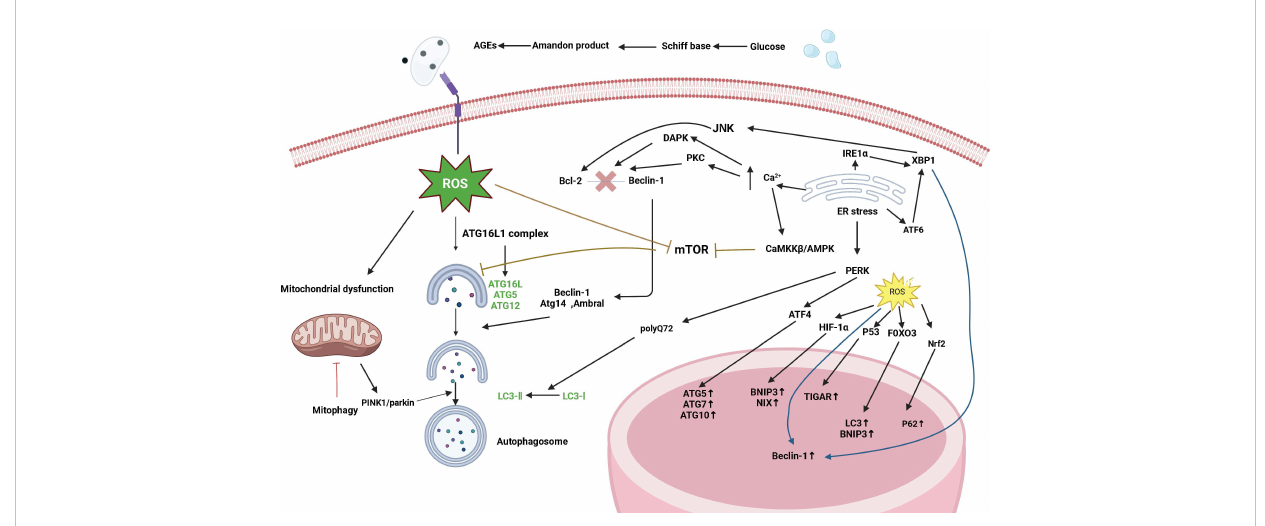
FIGURE 2 Signaling pathways are regulated by autophagy in diabetes. Diabetes affects autophagy through the following pathways: oxidative stress, endoplasmic reticulum stress, mTOR-dependent signaling pathway, and the AMPK pathway. Autophagy maintains ROS levels by removing partially depolarized mitochondria, and ROS can activate autophagy by inhibiting mTOR, increasing Beclin-1 expression, and converting LC3-I to LC3-II. ROS can act as signaling molecules that activate JNK-1, and large amounts of ROS lead to the opening of the mitochondrial permeability transition pore, which disrupts mitochondrial membrane potential and leads to the onset of PINK1/parkin-mediated autophagy. ROS can also induce autophagy through regulation at the transcriptional level (in the nucleus) and translational level (in the cytoplasm), and an increase in ROS activates the transcription factors HIF-1 a , p53, FOXO3, and Nrf2 and promotes the transcription of BNIP3, NIX, TIGAR, LC3, and p62. Endoplasmic reticulum stress induces autophagy through the UPR pathway and endoplasmic reticulum Ca2+ transport. The IRE1 a pathway activates the cJun-N-terminal kinase (JNK) pathway and modi fi cation of x-box binding protein 1 (XBP1) mRNA by a shift mutation. The ATF6 pathway regulates other UPR members including XBP1. The PERK pathway affects autophagy by inducing the transcription of autophagy-related genes such as ATG5, ATG7, and ATG10 through ATF4. The PERK pathway also facilitates the conversion of LC3-I to LC3-II induced by polyglutamine 72 (PolyQ72). In the early stages of endoplasmic reticulum stress, activated IRE1 a phosphorylates Bcl-2, which is involved in the induction of autophagy, via the JUK pathway, leading to the separation of Bcl-2 from Beclin-1. In addition, another participant of the XBP-1-IRE1 a pathway promotes Beclin-1 transcription. ATF6 is indirectly involved in autophagy by inducing XBP-1 transcription. Under ER stress, excessive Ca2+ entry into the cytoplasm induces autophagy through three different mechanisms: Stimulation of the CamKK/AMPK-dependent pathway leading to mTOR inhibition; Activation of death-associated protein kinase (DAPK) by participating in the phosphorylation of Beclin-1; and activation of the PKC pathway leading to Bcl2-Beclin-1 complex